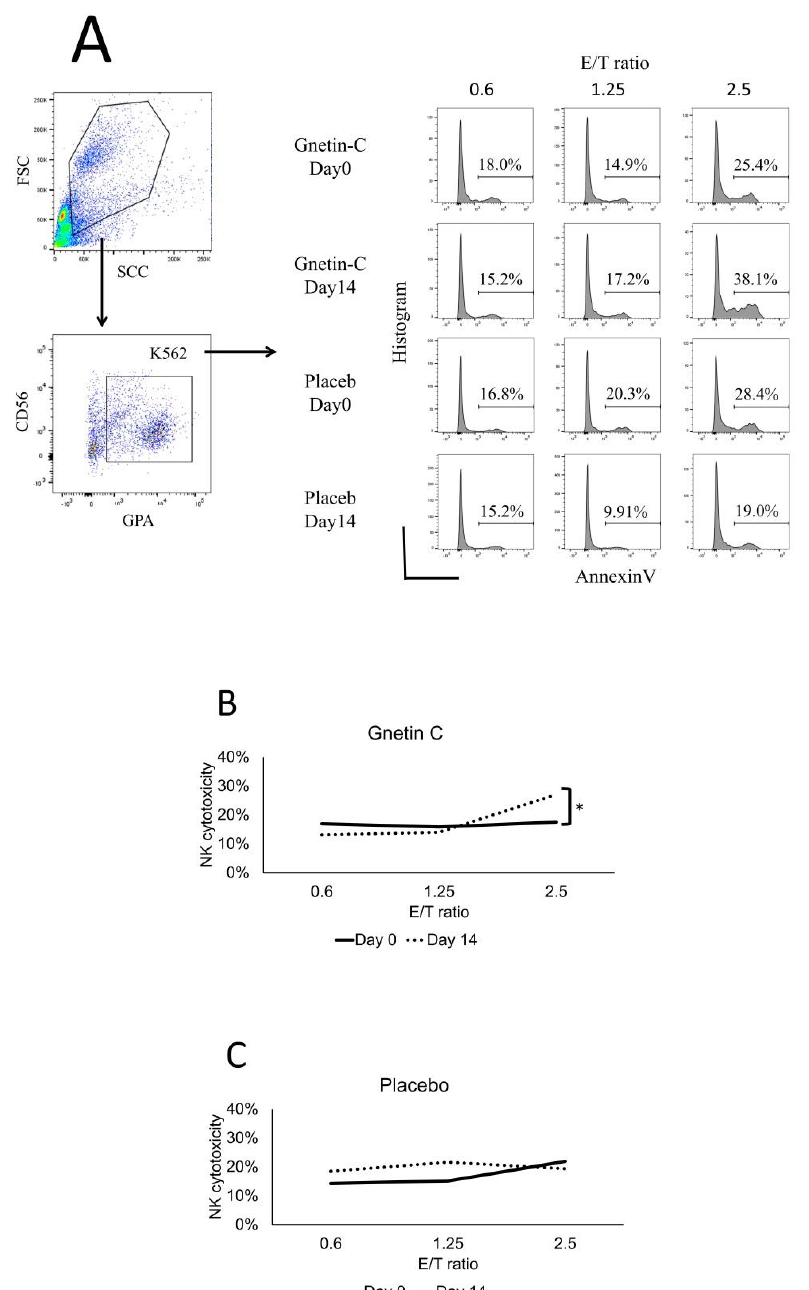
Figure 6. ( A ) The cytotoxicity of NK cells against K562 cells in Gnetin-C; A representative flow cytometry scattergram indicating the increase in the proportion of apoptotic K562 cells (as indicated by Annexin V expression) when exposed to NK cells obtained from healthy subjects after Gnetin-C supplementation and placebo. Summarized cytotoxicity data of NK cells derived from individuals in the ( B ) Gnetin-C group and ( C ) placebo group, before and after the intervention, as determined by an